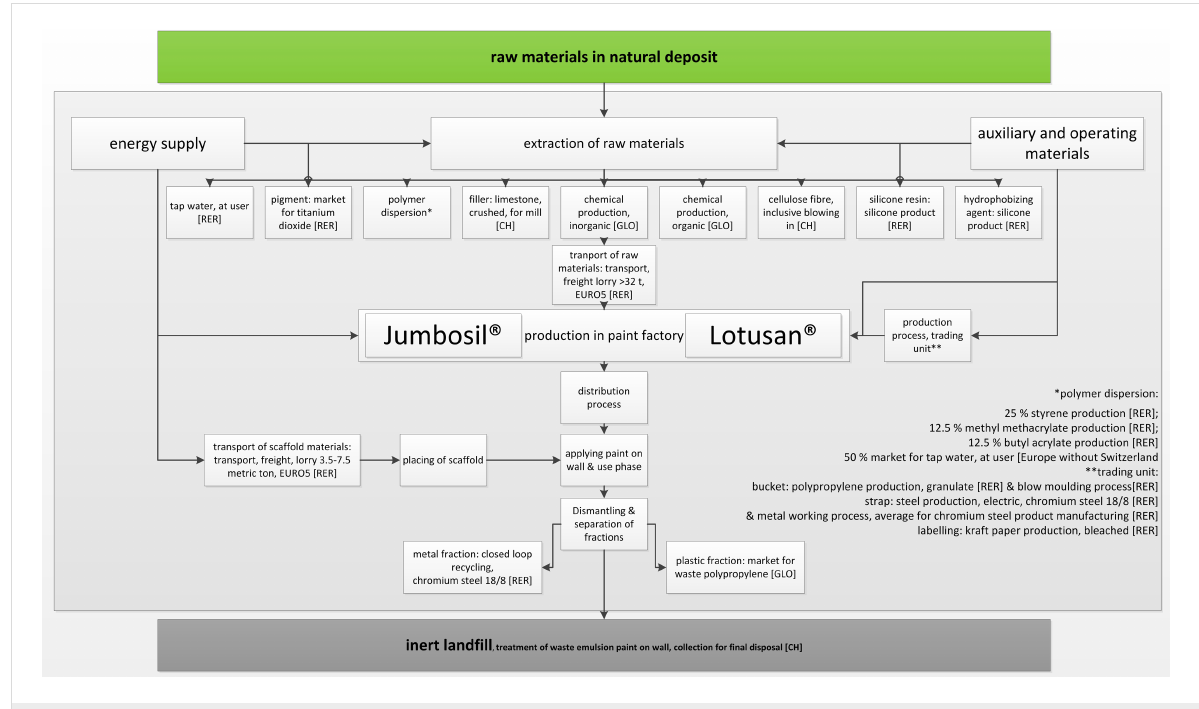
Figure 2: Schematic drawing of the system boundary with production and life-cycle steps for the two compared façade paints Lotusan ® and Jumbosil ® from cradle to